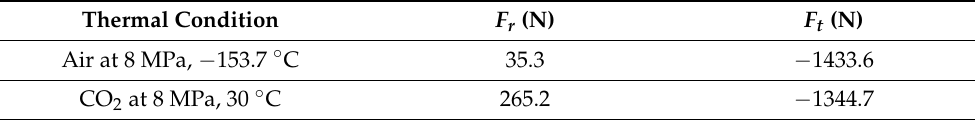
Table 1. Forces acting on the shaft with various conditions ( ε = 0.25 and 30,000 rpm) Thermal